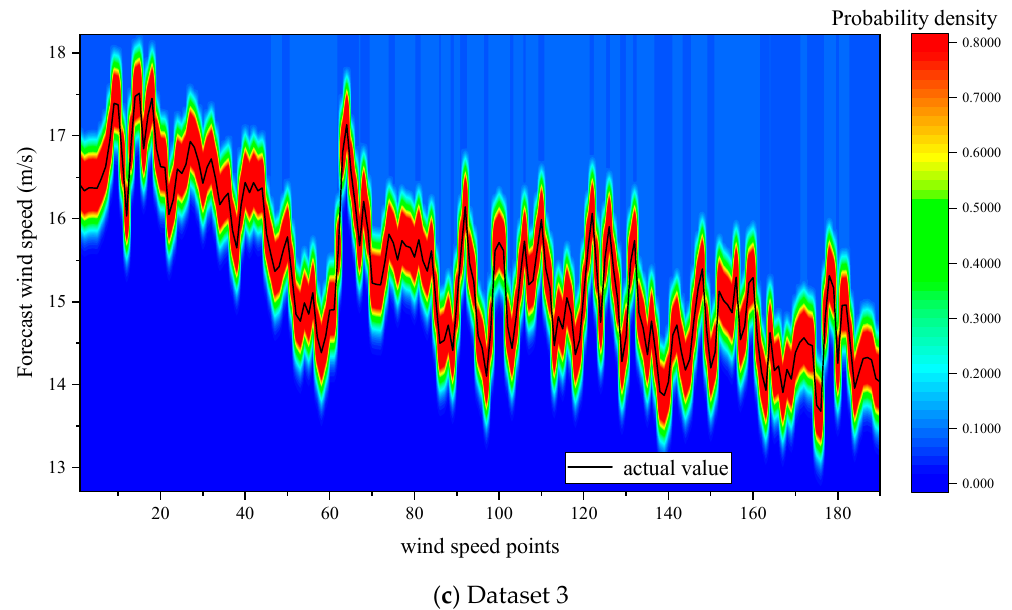
Figure 6. Probability distribution of forecast and measured wind speeds.